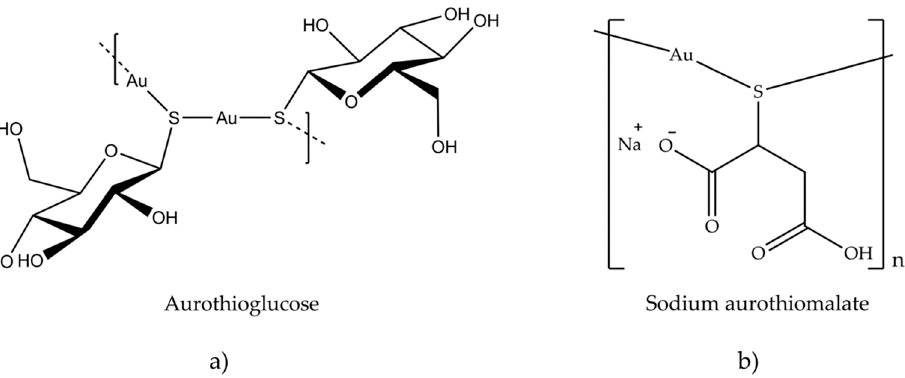
Figure 9. Chemical structure of ( a ) aurothioglucose and ( b ) sodium aurothiomalate. The in vitro cytotoxicity of several gold compounds against B16 melanoma and P388 leukemic cells was examined in a study of auranofin and similar compounds [81]. The result shows that a wide variety of gold (I) phosphine thiolates possesses a significant cytotoxic activity. The presence of a phosphine or arsine as a binder has resulted in an increase in cytotoxicity and in vivo antitumor activity against P388 leukemia, compared to other species. The importance of the type of phosphine, used in the binuclear gold (I) compounds containing bidentate phosphines, was tested in vivo against leukemia P388, by systematically varying the nature of the phosphine and keeping the thiolate, R1S − , constant. The most active compound was the one containing (CH 3 CH 2 )[(CH 3 ) 2 CH] P (Figure 10a), while the least active one had (C 6 H 5 ) 2 P (Figure